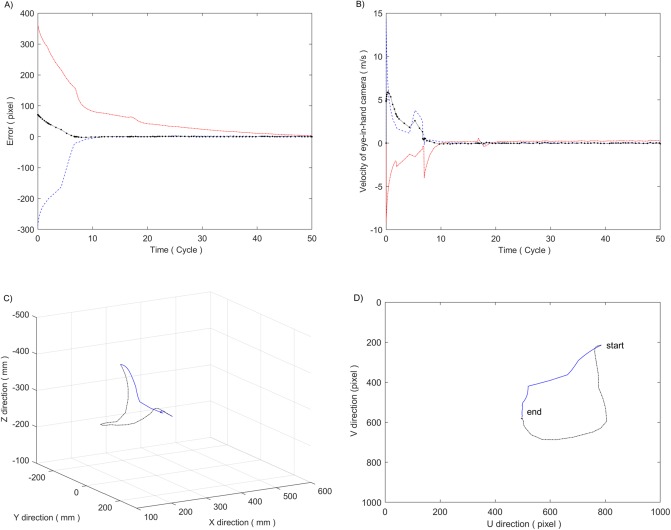
Results of the improved potential field method.(A) Error tracking curve. Where the error tracking curve of moment feature 1 is designated with a blue dotted line, the error tracking curve of moment feature 2 is designated with a red dash-dotted line, and the error tracking curve of moment feature 3 is designated with a black pecked line. (B) Velocity of the eye-in-hand camera. Where the velocity in X direction is designated with a blue dotted line, the velocity in Y direction is designated with a red dash-dotted line, and the velocity in Z direction is designated with a black pecked line. (C) Motion trajectory in Cartesian space. Where the simulation result of potential field method is designated with a blue solid line, and the simulation result of image moment method is designated with a black dash-dotted line. (D) Motion trajectory in image space. Where the simulation result of potential field method is designated with a blue solid line, and the simulation result of image moment method is designated with a black dash-dotted line.